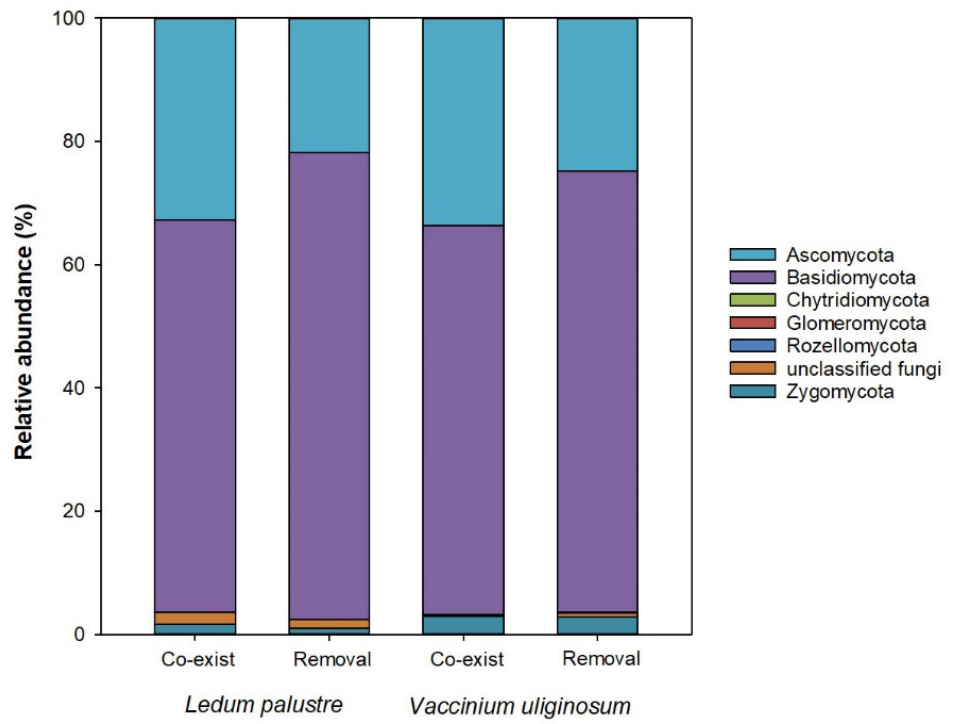
Figure 3. Relative abundances of soil microbial phyla in communities dominated by Ledum palustre and Vaccinium uliginosum in the interruption treatment of dominant species removal and an untreated control of both species co-existing. Classifications of microbial phyla are given in the figure legend whereas some mycorrhizal fungi are unclassified.